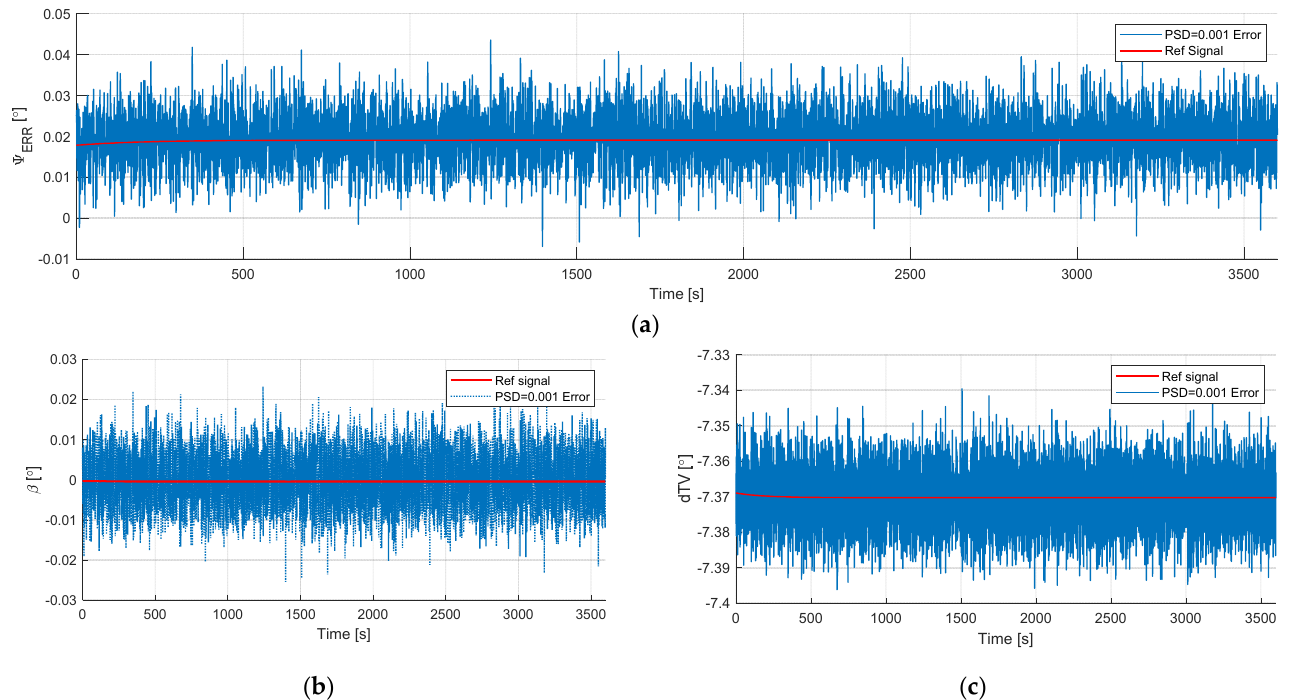
Figure 13. Influence of white noise of TSoS on a stable flight: ( a ) Comparison of heading error; ( b ) Comparison of angle of sideslip; ( c ) Comparison of rudder trimmer deflection.